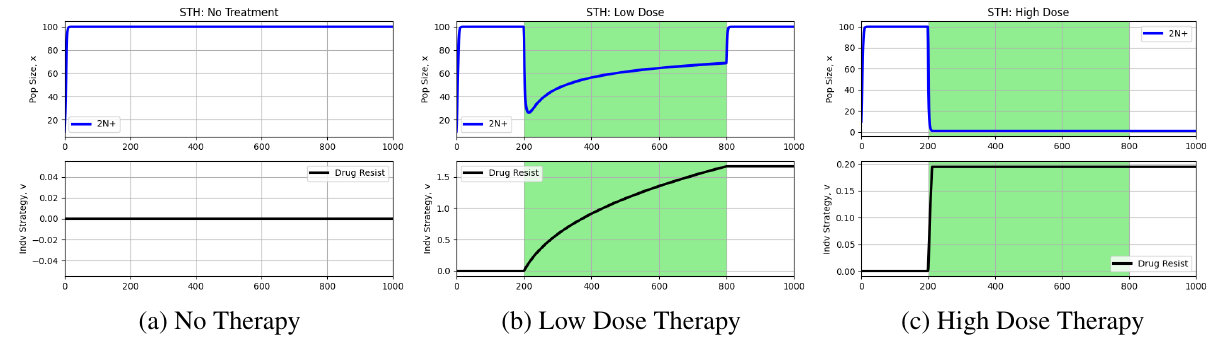
Figure 1. Simulations under standard tumor heterogeneity hypothesis. The black curve captures the evolutionary dynamics of resistance White and green backgrounds reflect periods without and periods with treatment, respectively. The rate of evolution under the standard tumor heterogeneity hypothesis is enough to stave off extinction and undergo evolutionary rescue when faced with a low dose therapy. However, under high dose therapy, the cancer cells cannot evolve fast enough to remain